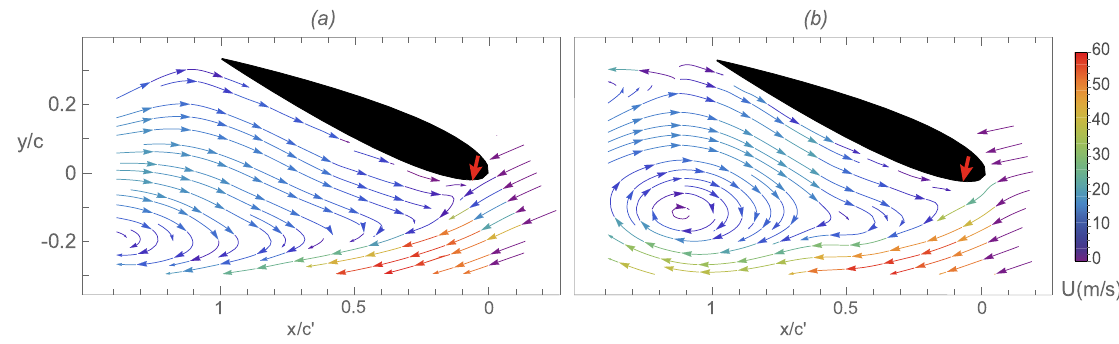
Figure 12. ( a ) Plasma-off and ( b ) plasma-on flow field at T A for α = 22 ◦ and U ∞ = 20